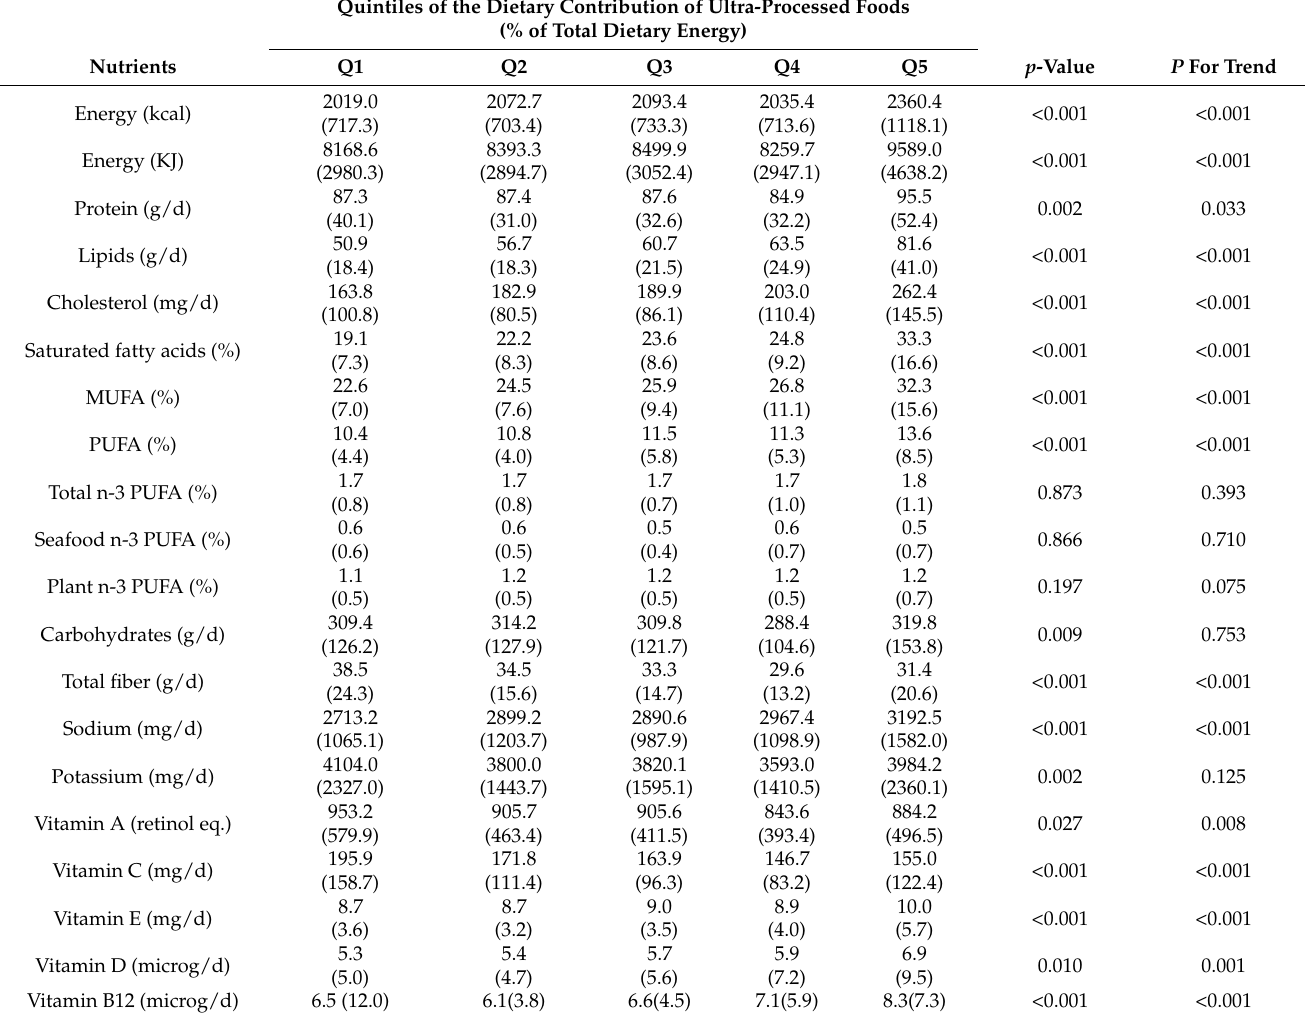
Table 3. Mean total energy intake and nutrient content of the overall diet according to quintiles of the energy share of UPFs in the study sample ( n =